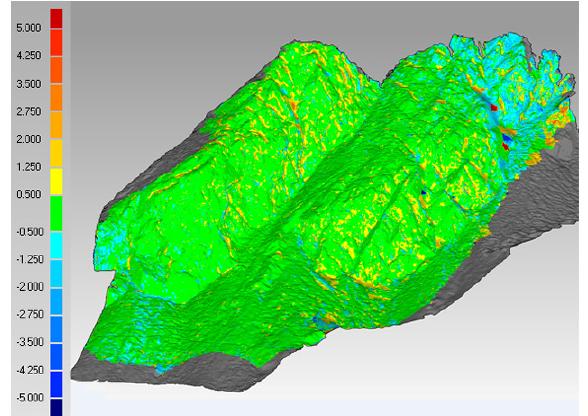
Figure 4. Relative comparison of photo-based and laser scanning-based models